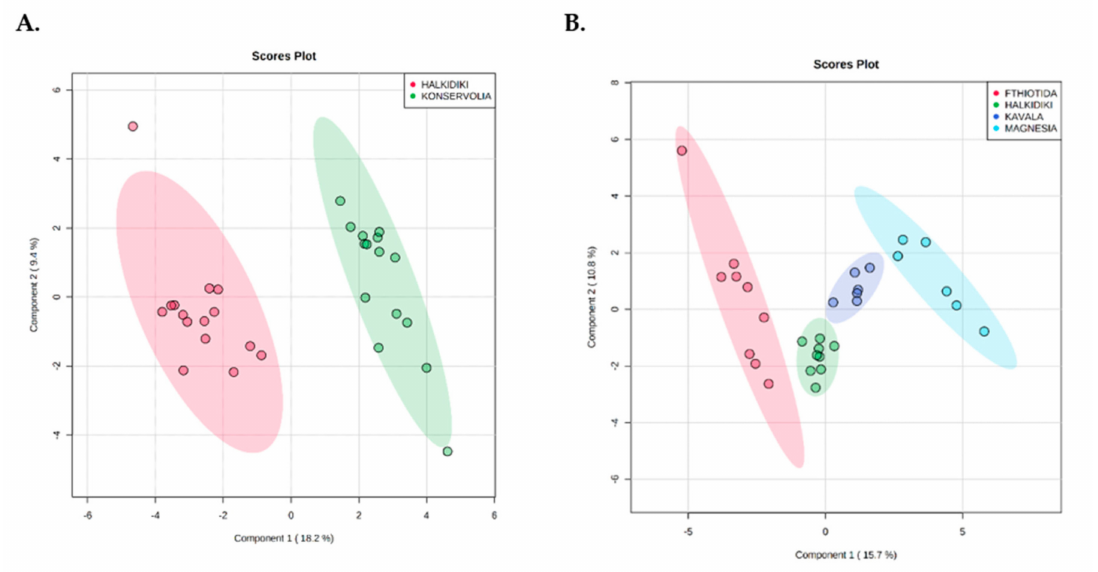
Figure 8. Partial least squares discriminant analysis (PLS-DA) clustering depending on ( A ) cultivar and ( B ) geographical origin of the olive samples.